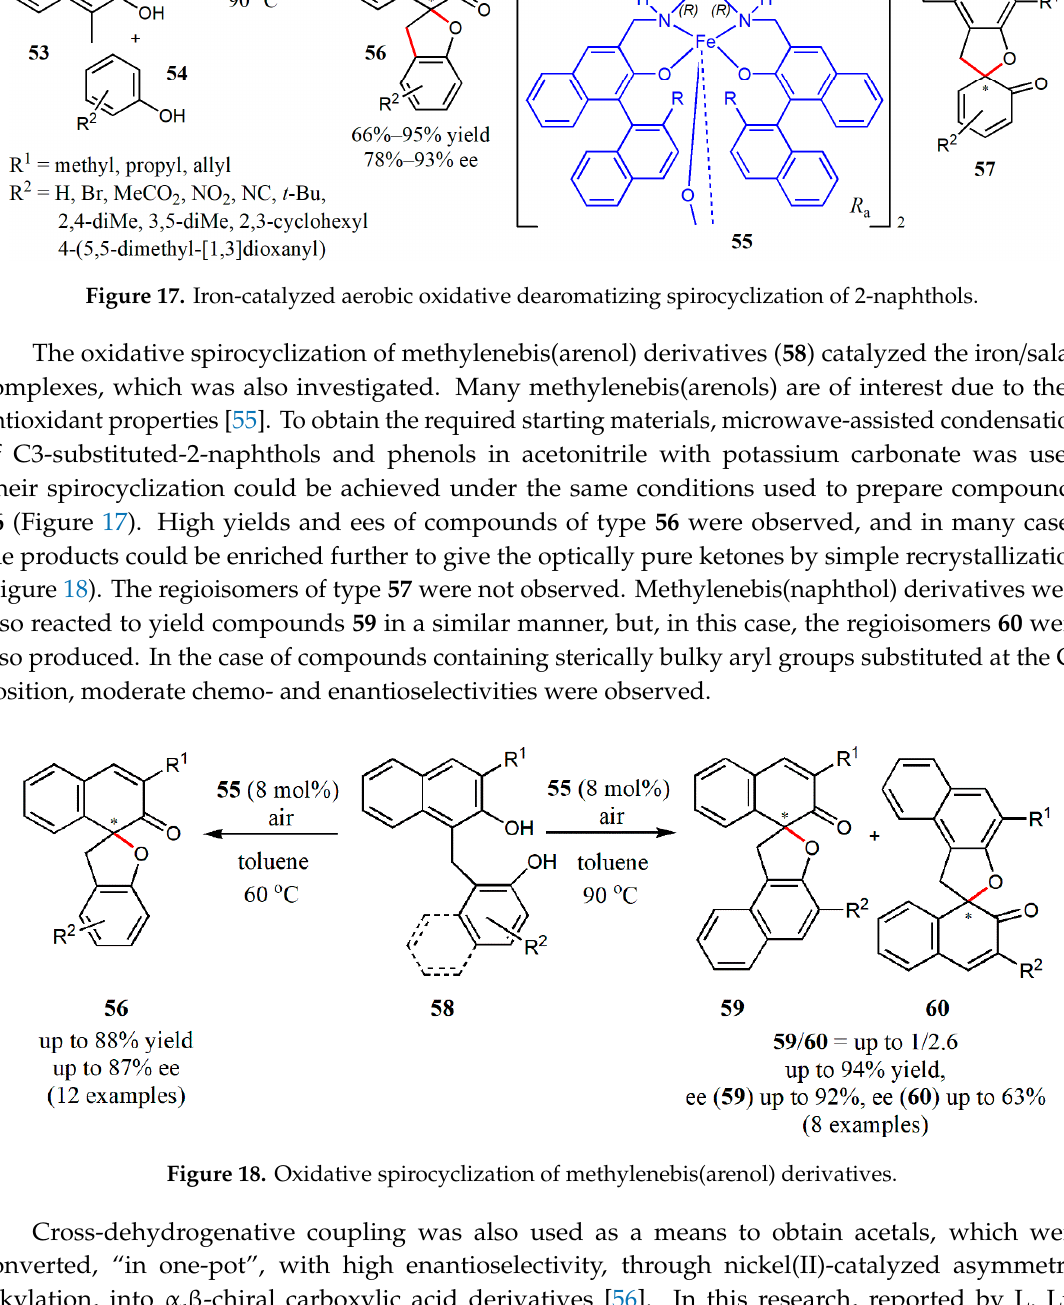
Figure 19. Enantioselective CDC of saturated ethers with carboxylic acid derivatives. One limitation of the method was the fact that α -aryl- or α -alkenyl acetic acid derivatives had to be used since no product could be obtained with the α -alkyl derivatives, e.g., 66a (R 4 = Et, X = S). The oxa- and thiazolidinethione moieties could also be easily removed if wished, by reduction with diisobutylaluminum hydride (DIBAL-H), followed by treatment with Ru(PPh 3 ) 3 Cl, to afford α -chiral ethers with very high degrees of enantiopurity.